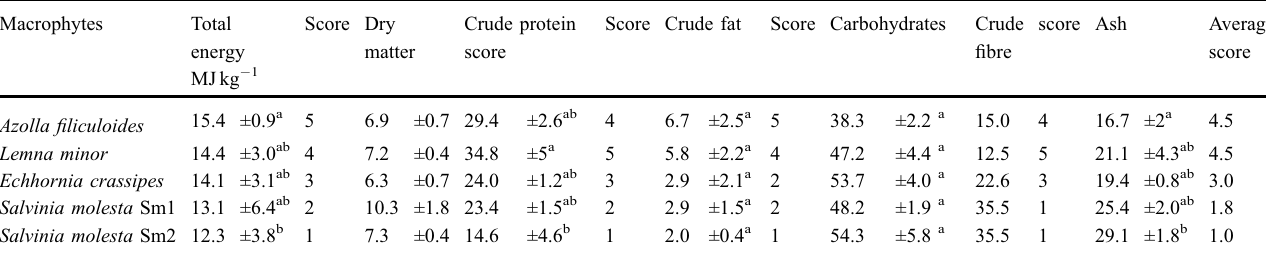
Table 1. Proximate analysis of fi ve fl oating aquatic macrophytes and relative scores related to nutritional value. Except for crude fi bre (*), all data are expressed as the mean± SEM (standard error of the mean; n =3) and are expressed in percentage of dry matter (% DM). Values in the same column with the same letter are not signi fi cantly different at P > 0.05. (*) Only one